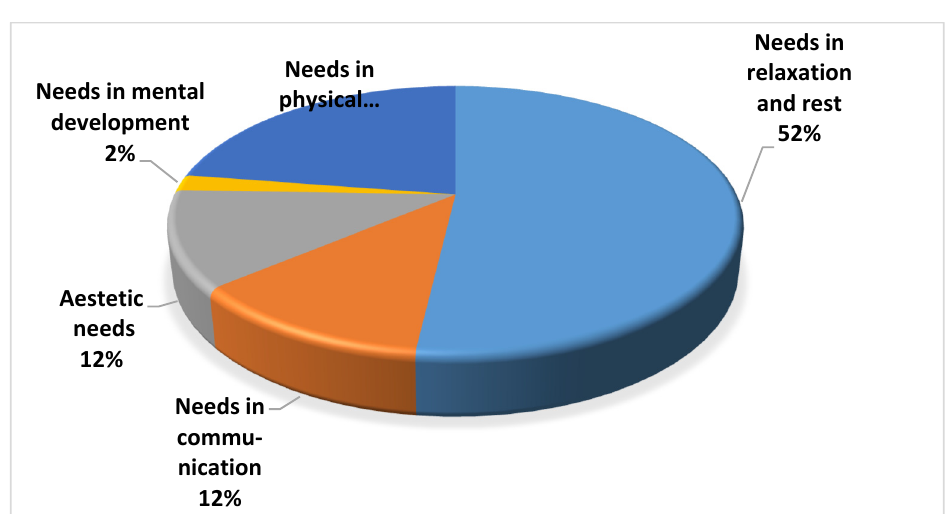
Figure 2. Percentage distribution of the respondents among the main drivers for forest recreation activities.